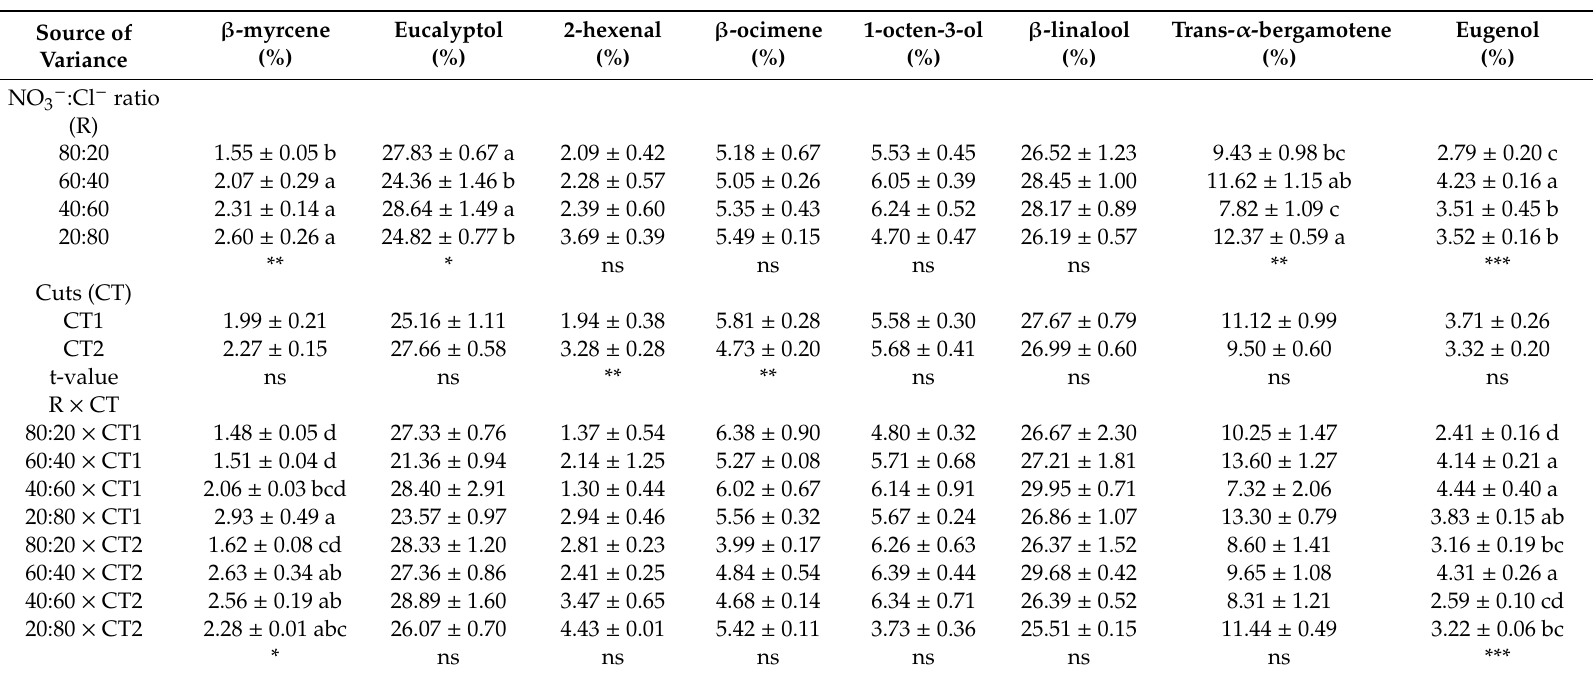
Table 5. Analysis of variance and mean comparisons for the relative abundance of major aroma volatiles in greenhouse basil cultivated under four NO 3 − :Cl − ratios (R) in the nutrient solution and harvested in two successive cuts (CT).